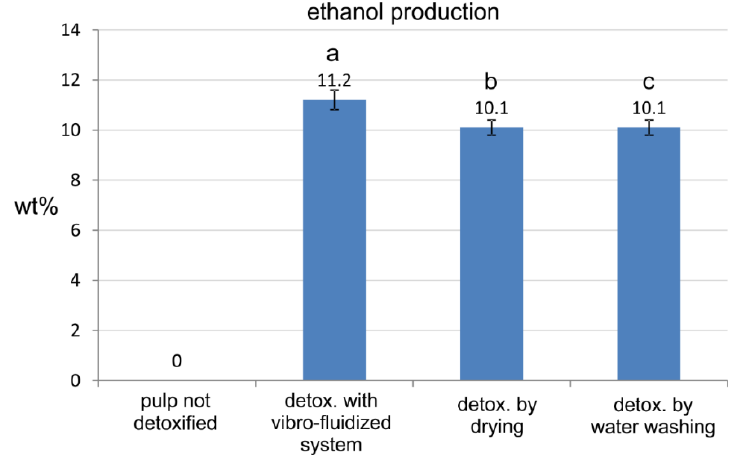
Figure 6. Ethanol production after different detoxification methods, as g/g × 100 of dry pre-treated biomass. The Tukey HSD test (significance level 0.05) gives p < 0.015 for a–b and a–c, while no difference results between b and c ( p = 1).